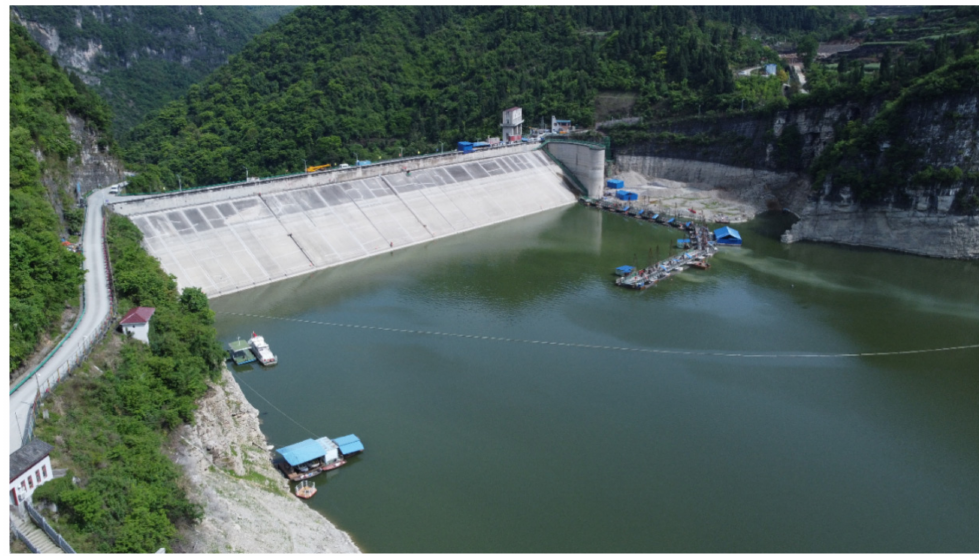
Figure 5. Real photos from the